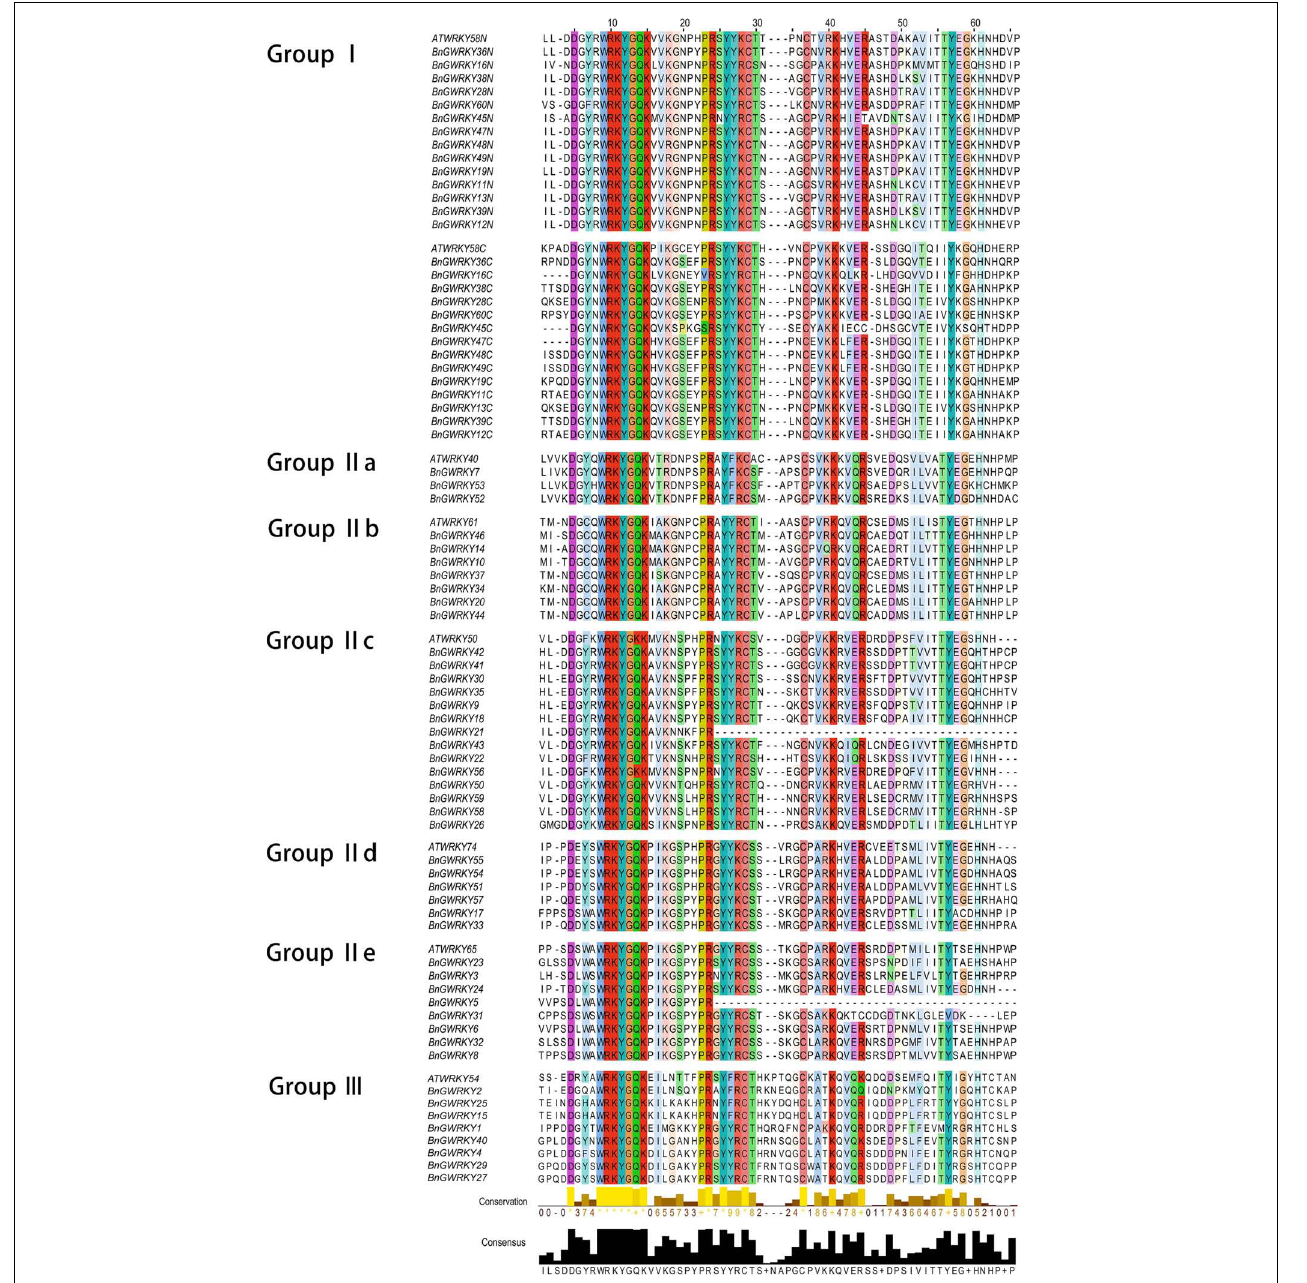
FIGURE 1 | Multiple sequence alignment of the WRKY domains of BnGWRKY and selected AtWRKY domain. “N” and “C” indicate the N-terminal and C-terminal WRKY domain of a specific WRKY protein.